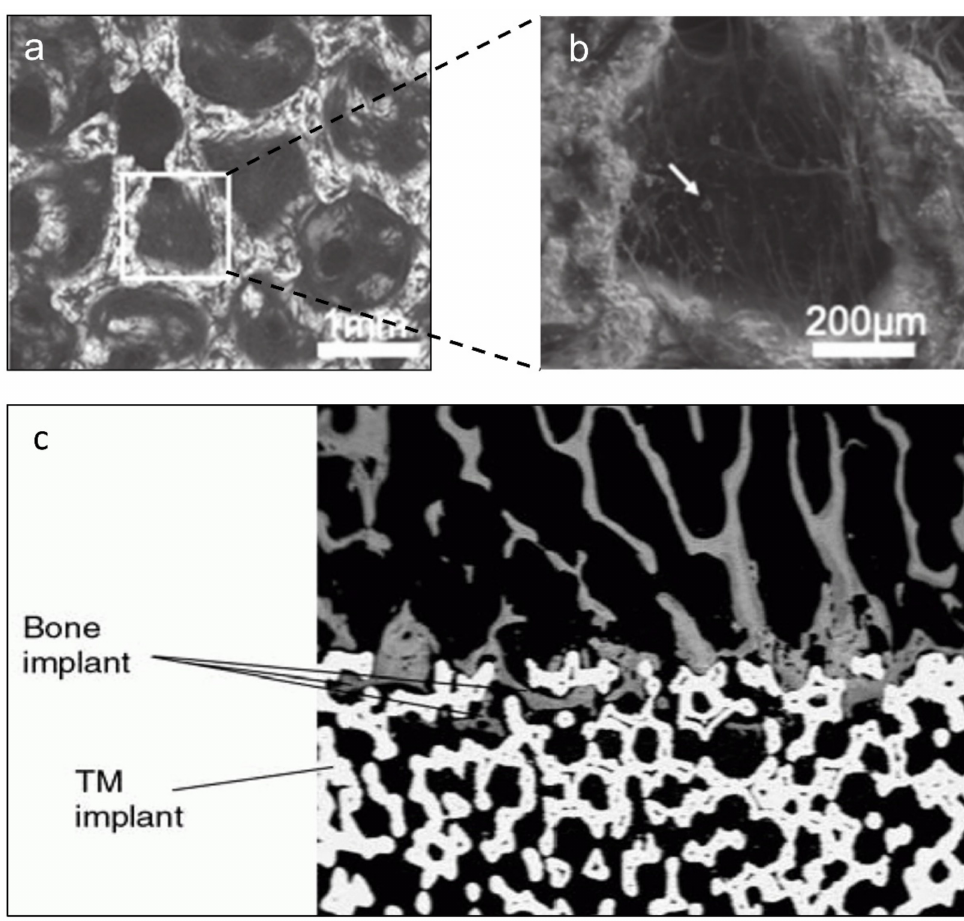
Figure 2. The microstructure of porous Ta presented as honeycomb structure ( a ), and cells that partially cover the cavity with many calcium nodules (indicated with white arrow) can be detected ( b ). Reprinted from ref. [36]. Abundant bone ingrowth can be found in the pores of porous Ta implant ( c ). Reprinted with permission from [45]. Copyright © 2021 by American Academy of Orthopaedic